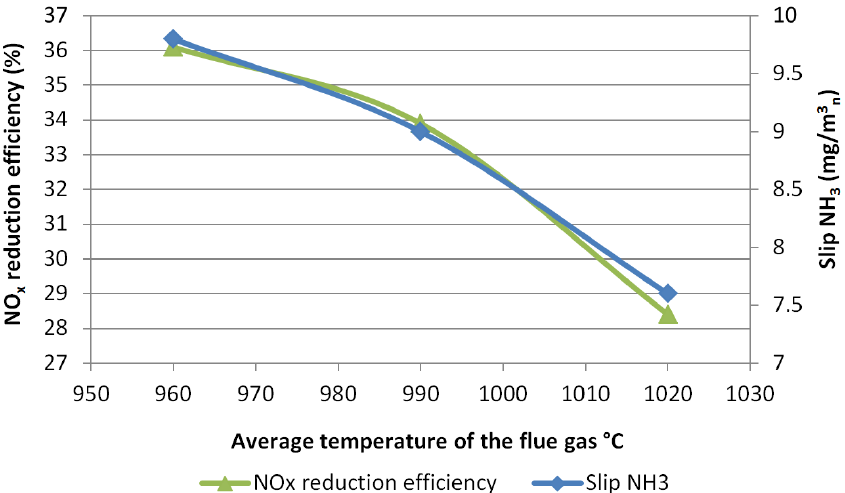
Figure 14. Relationship of the NO x reduction (%) and NH 3 slip content converted to 6% of O 2 in dry flue gas (mg/m 3n ) on average flue gas temperature (°C).